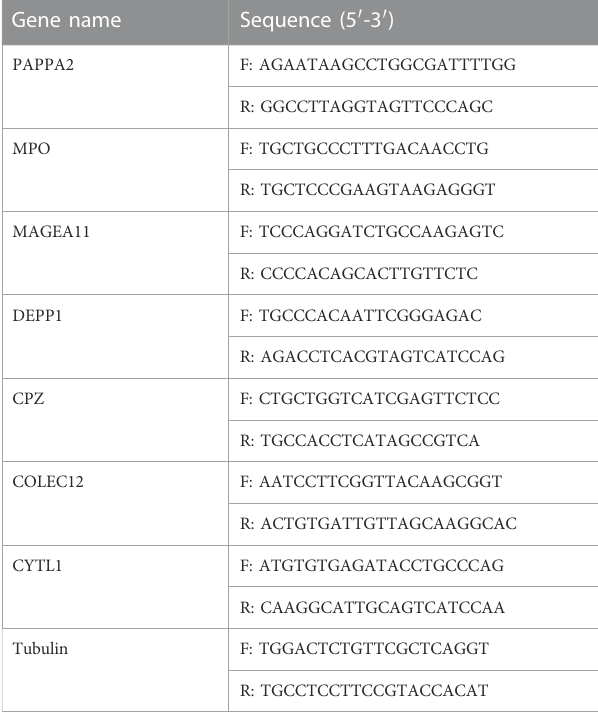
TABLE 1 The information of primers for